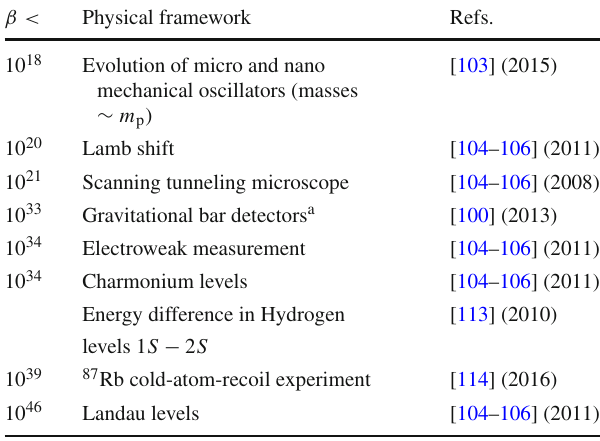
Table 2 Upper bounds on β derived from non-gravitational experi- ments β < Physical framework